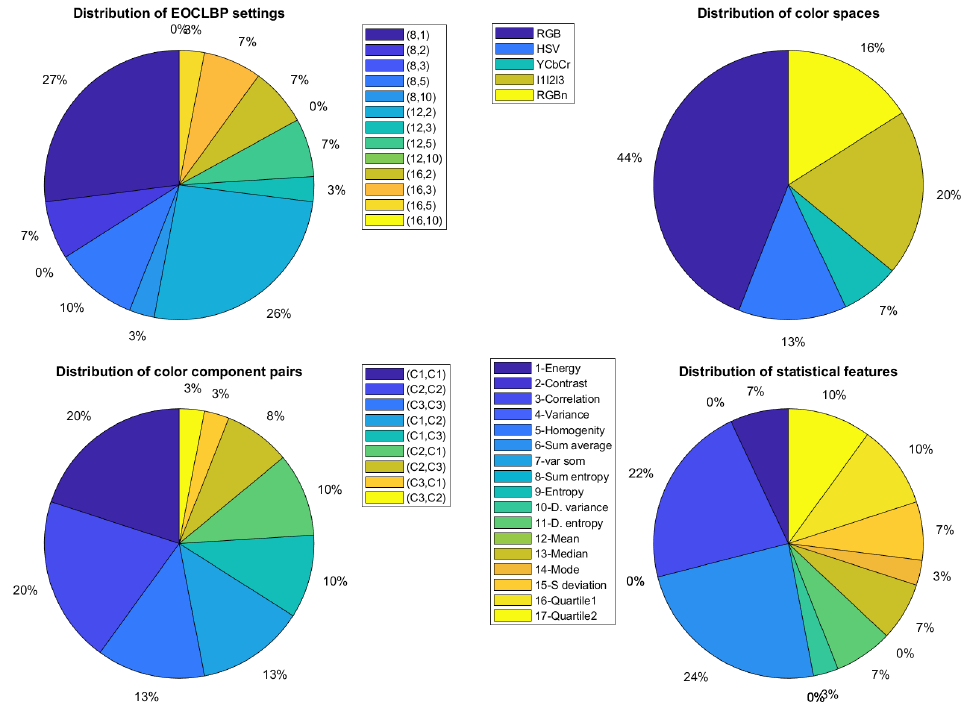
Figure 11. Distribution of the selected features for the EOCLBP descriptor with the MPMC repre- sentation for the USPtex dataset. This distribution is shown for the descriptor settings, color spaces, color component pairs and statistical features.